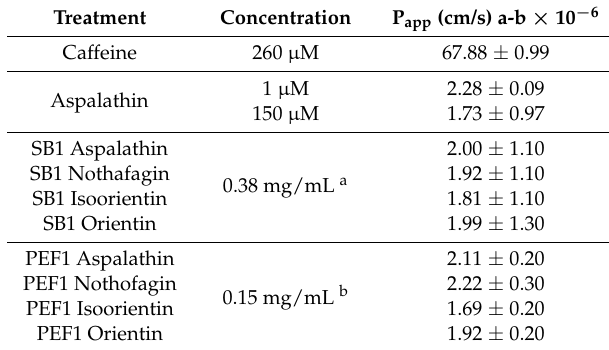
Table 4. Rate of transport and concentrations tested of aspalathin from a buffered solution of synthetic aspalathin, as well as aspalathin and other major flavonoids from buffered solutions of aspalathin-enriched green rooibos extract (SB1) and semi-purified fraction